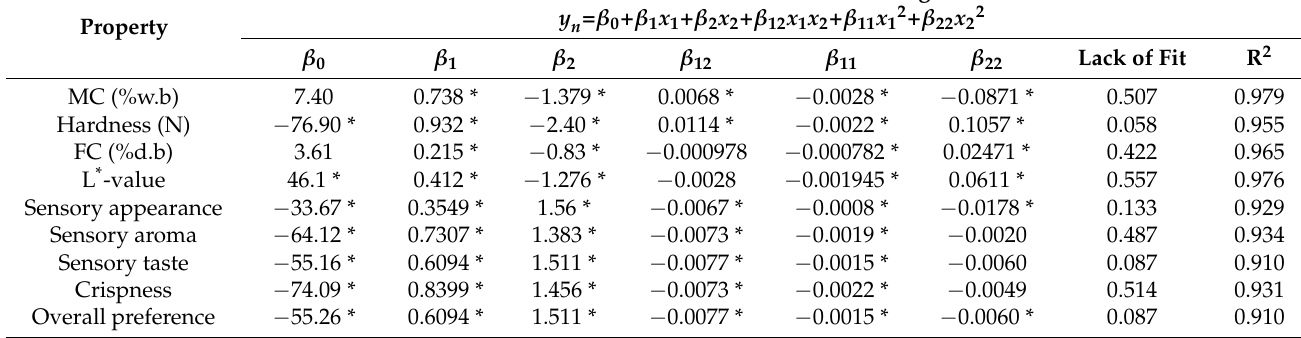
Table 2. Statistical constants of the second-degree polynomial equation for the quality and sensory properties of the air-fried falafel.